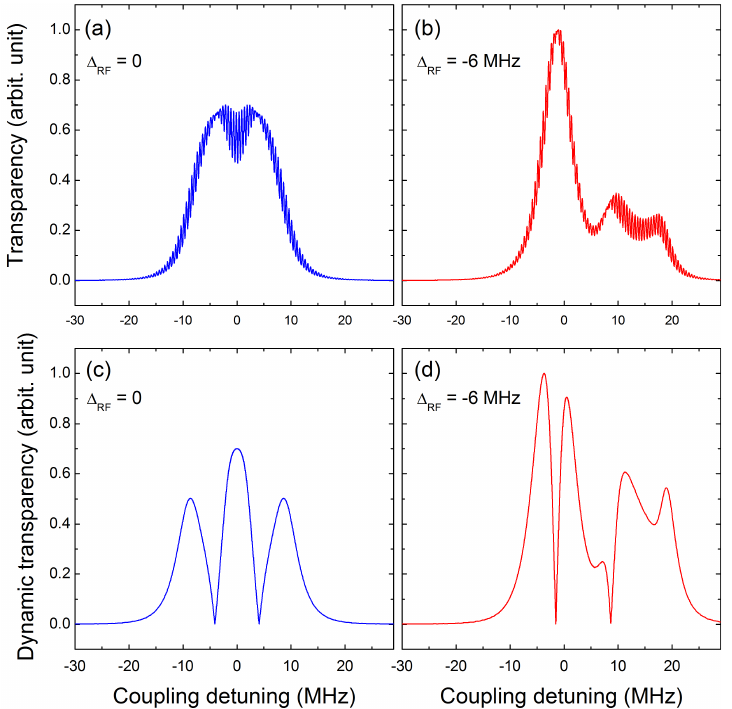
Figure 9. Theoretical simulation of the dynamical optical response for the RF detuning. ( a , b ) are the probe transparency signal under the 1 kHz modulation at zero and − 6 MHz RF detuning, respectively. Their dynamic optical response extractions are shown in ( c , d ), where a little increase in signal can be obtained by RF detuning.